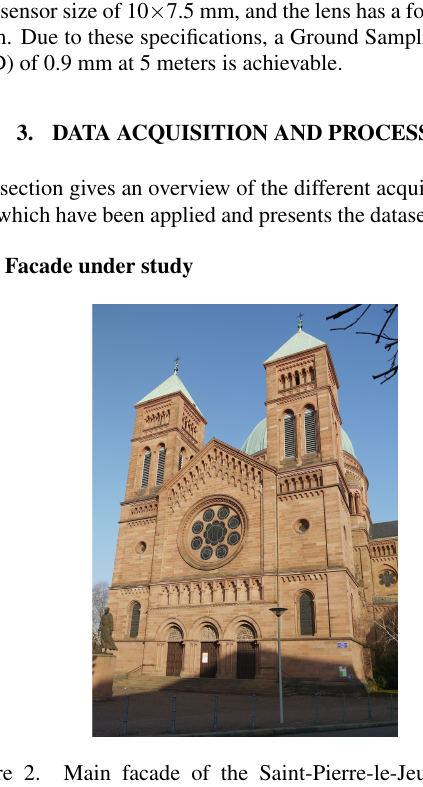
Figure 2. Main facade of the Saint-Pierre-le-Jeune